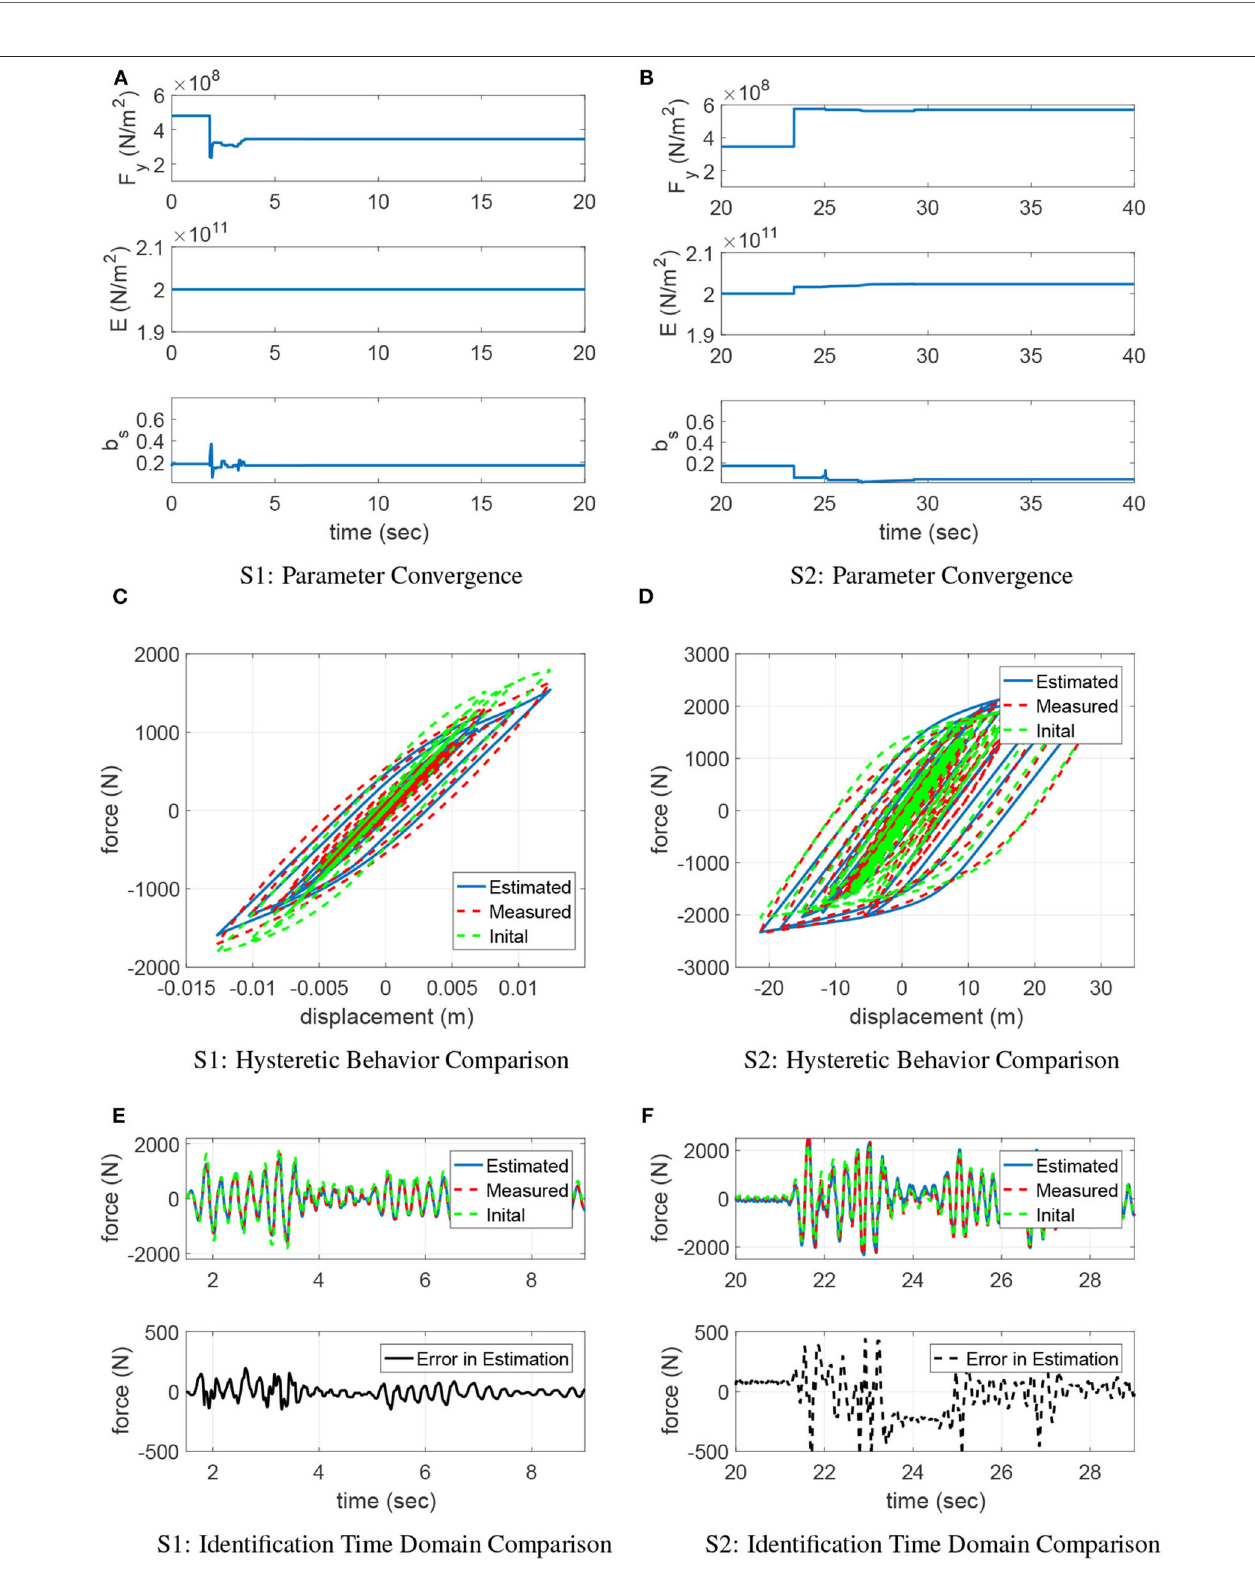
FIGURE 5 | Model updating performance case II. (A) S1: parameter convergence, (B) S2: parameter convergence, (C) S1: hysteretic behavior comparison, (D) S2: hysteretic behavior comparison, (E) S1: identification time domain comparison, (F) S2: identification time domain comparison.